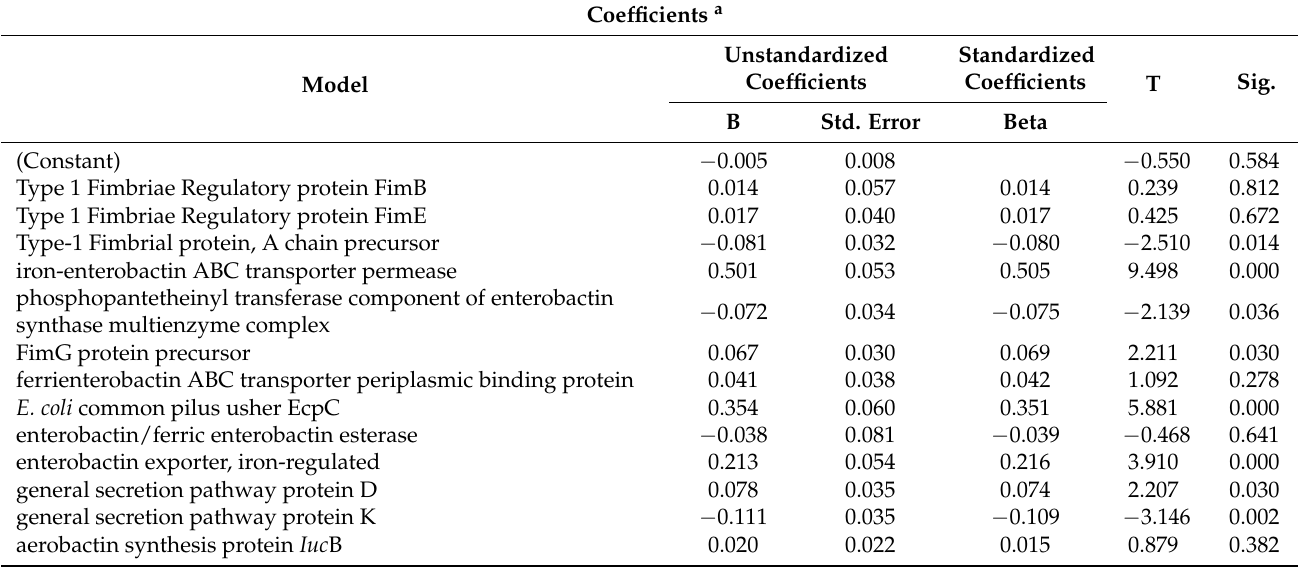
Table 1. Multivariate analysis of virulence factors detected in advanced stages of